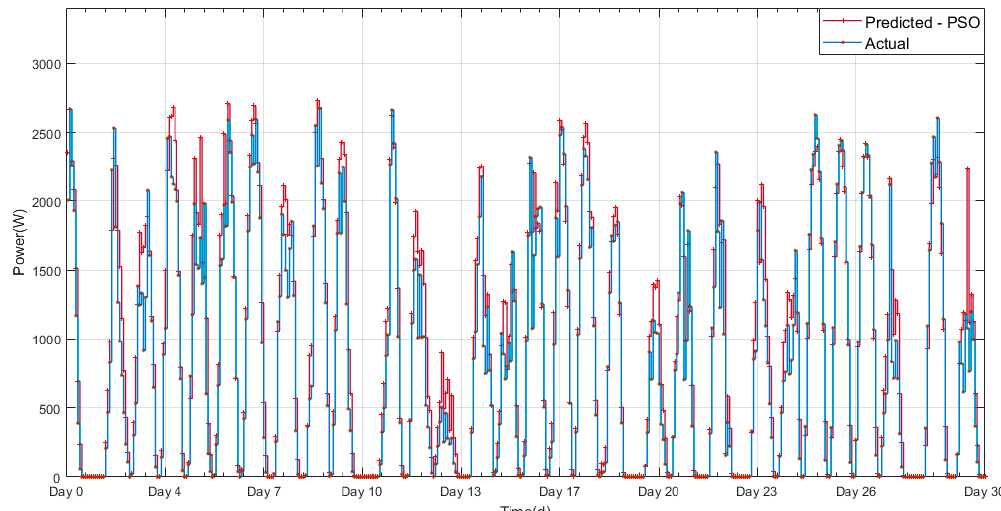
Figure 15. PSO-forecasted and actual values of PV output power.